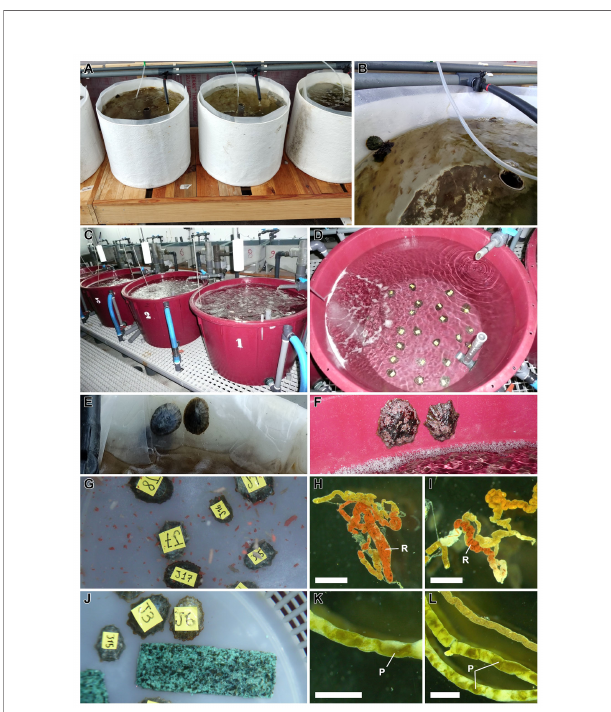
FIGURE 3 | Culture tanks used for the maintenance of adult limpets and feeding trials. Culture tanks from the AquaLab facilities, Azores (A, B) . Culture tanks from the CMC facilities, Madeira (C, D) . Limpets attached to the culture tank walls above the water level (E, F) . Feeding trials for adult specimens (G – L) . Commercial fi sh fl akes: fl akes available for the adult limpets (G) , and resulting feces (H, I) . Arti fi cial fl our-based meal: prepared meal available for the adult limpets (J) , and resulting feces (K, L) . Scale bar = 1 mm. R, red coloration derived from a fi sh fl ake; P, Porphyra piece from the arti fi cial meal.